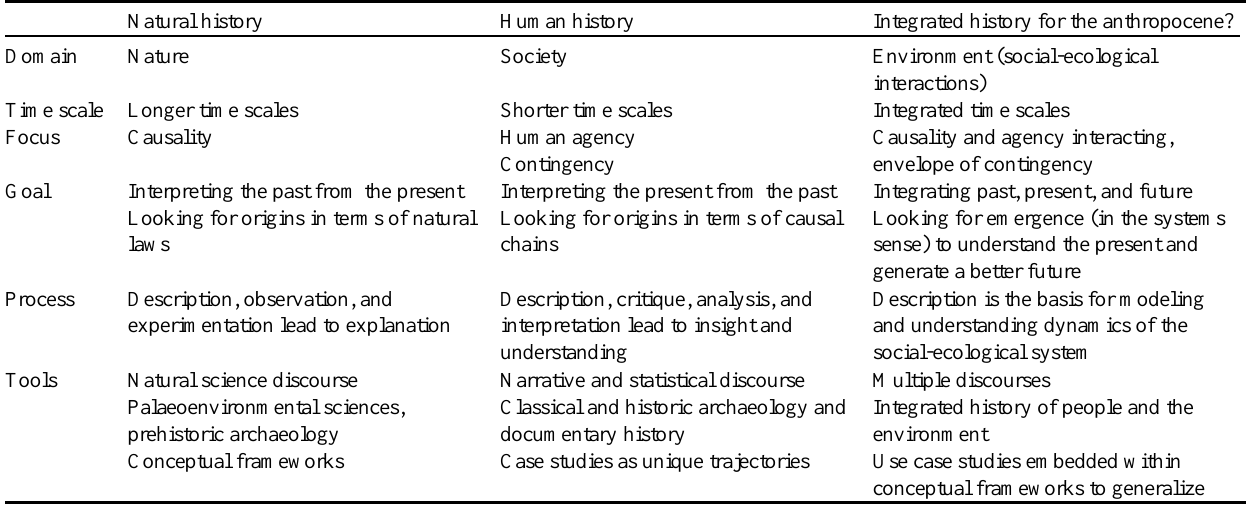
Table 1 . Integrating natural and human